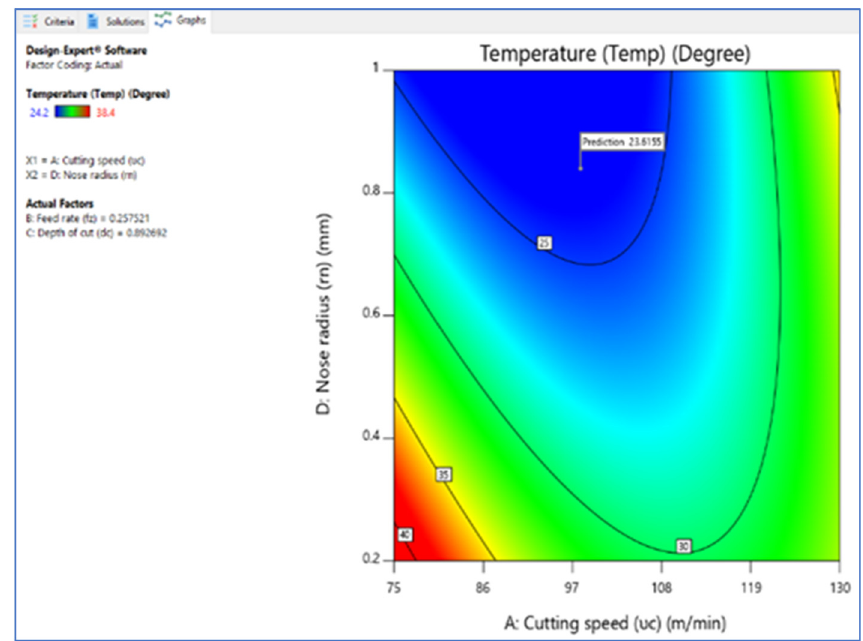
Figure 8. Contour plot on desirability (V c vs. R n ).